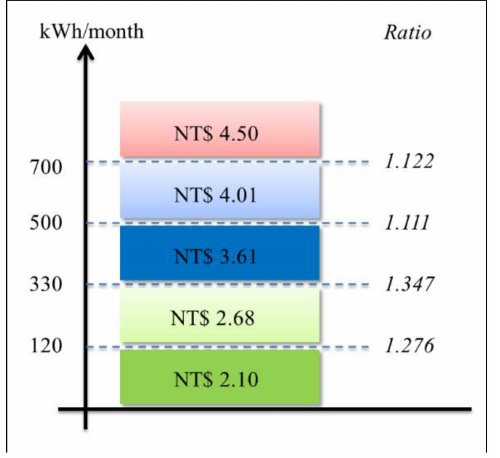
Figure 3. Five-level IBR used in this paper and announced by Taipower , a state-owned electric power industry (Taiwan Power Company, Taipei City, Taiwan) providing electricity to Taiwan and offshore islands of the Republic of China, in